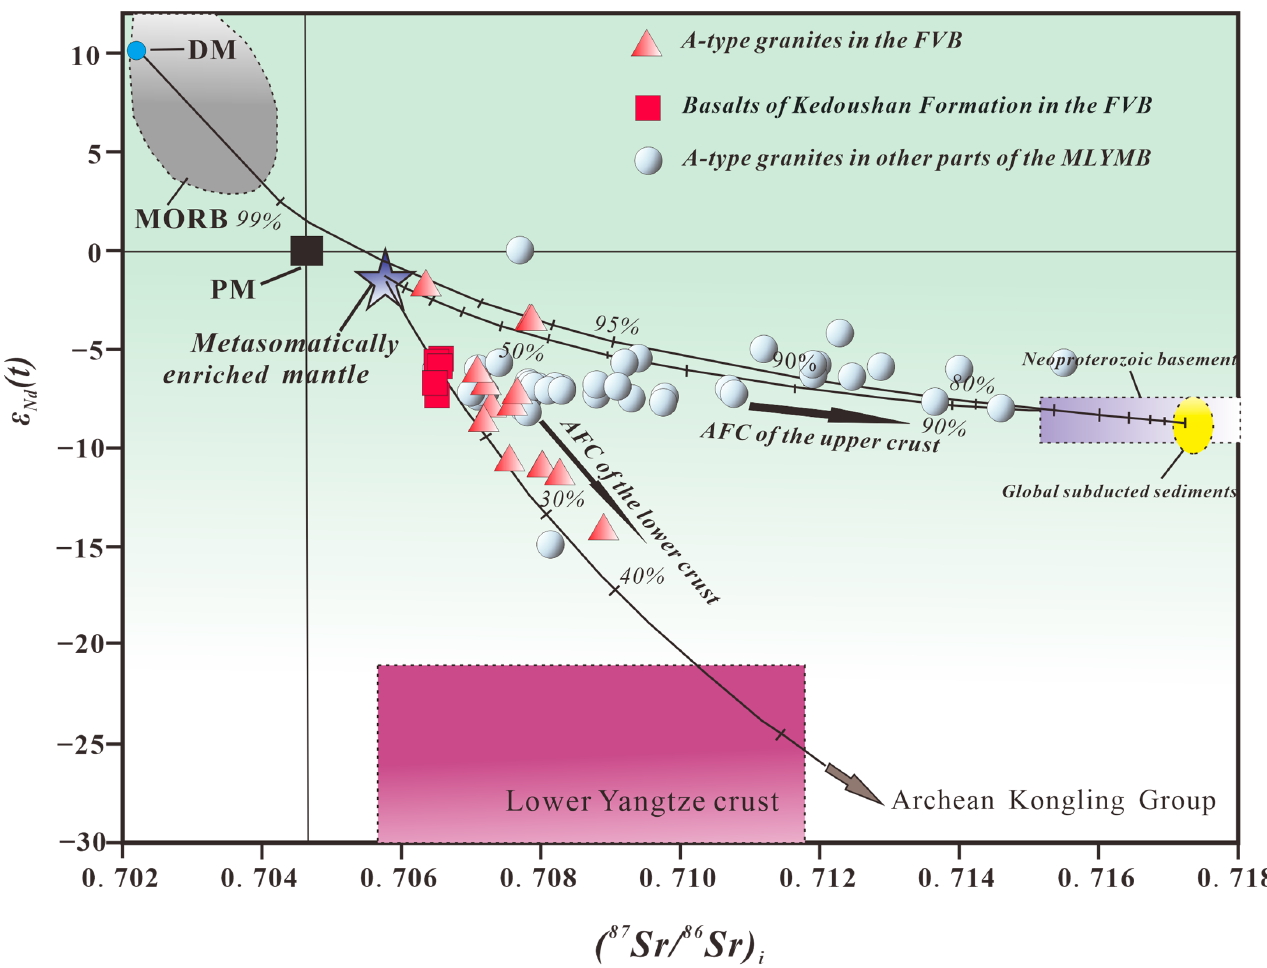
Figure 8. Diagram of initial ε Nd (t) vs. initial ( S7 Sr/ 86 Sr) i of A-type granites in the MLYMB. Data sources (see Supplement Table S3): Ocean basalt and primitive mantle [158]; metasomatically en- riched mantle [138]; global subducted sediments [159]; Neoproterozoic basement [160]; Lower Yangtze crust [161]; A-type granites of the FVB [86,89]; A-type granites of the MLYMB [91,93,94,96,100,101,108,110].